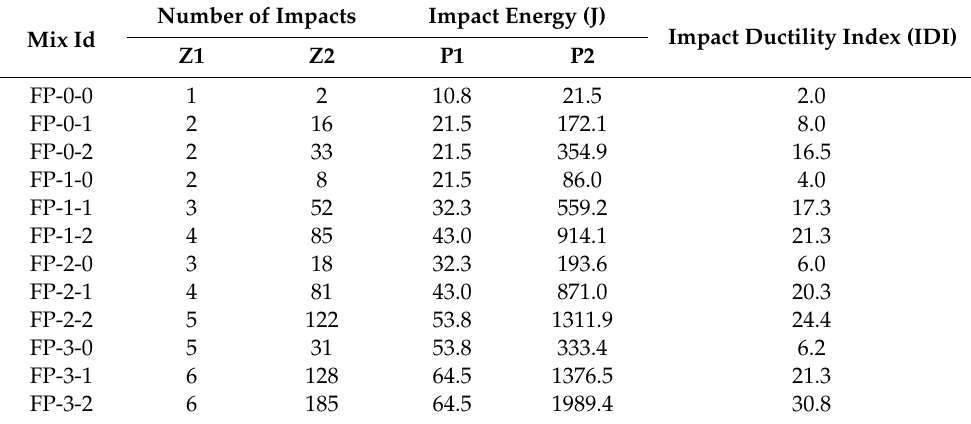
Table 3. Experimental finding from a drop weight test